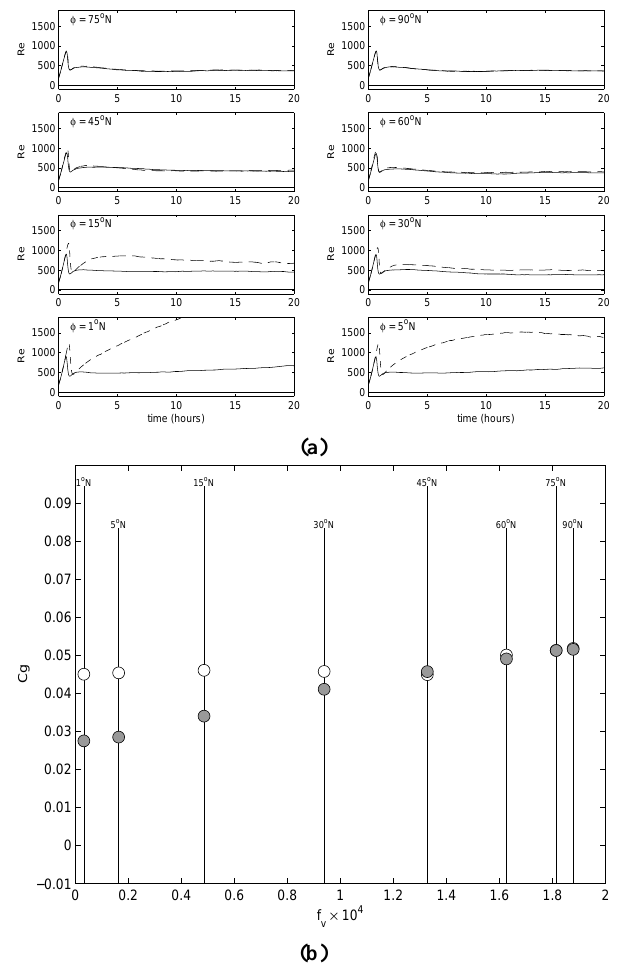
Fig. 2. The geostrophic drag coefficient C g = u ∗ /G : (a) time evo- lution of the effective Re = C − 2 g (solid curves are for EW-EBL; dashed curves are for WE-EBL); (b) values of the coefficient at hour six of the LES integration. Shaded circles show the WE-EBL; open circles, the